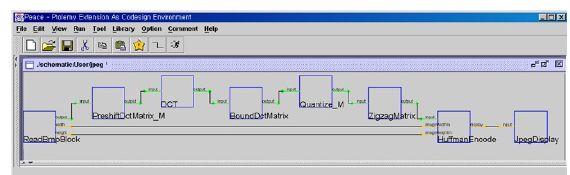
Figure 19: JPEG encoder example that represents a graph of same size samples without delays.